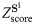
Effect of mutations on vibrations involved in ligand-binding (ZscoreSi) vs. evolutionary conservation (Zscoreevol,i).Linear regression line is included and linear correlation coefficient is shown in the top right corner.